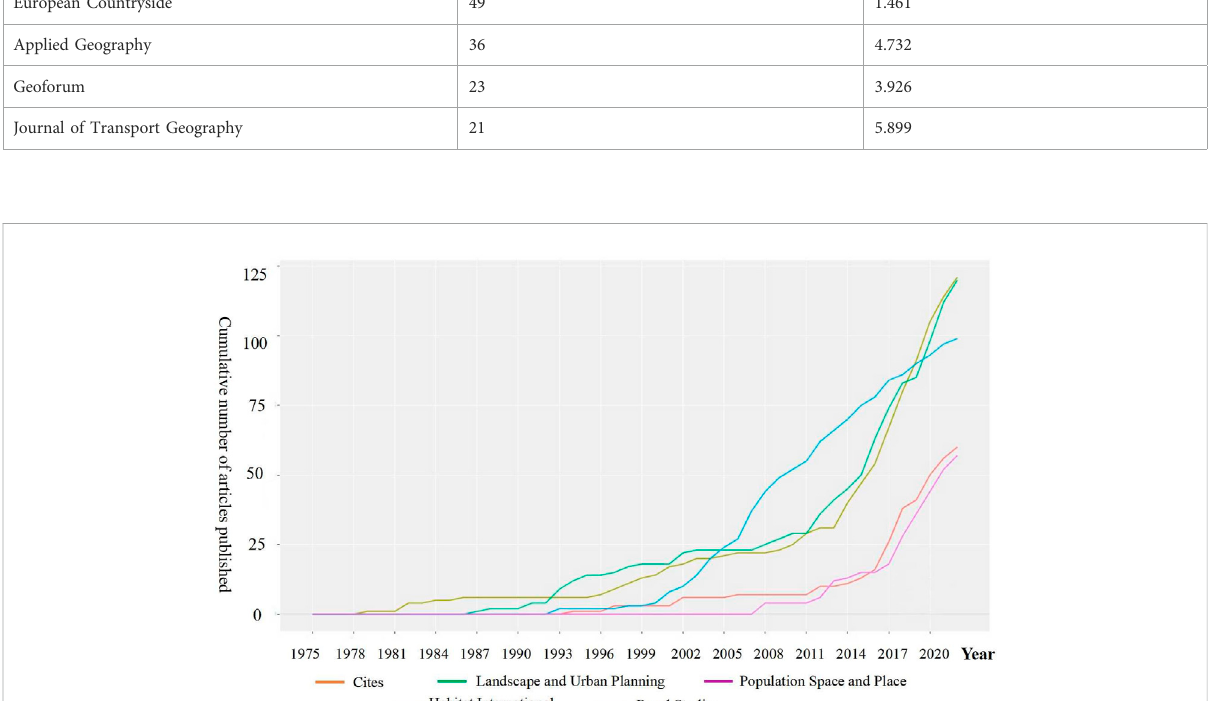
Time dynamics of publication volume of different journals in the fi eld of rural